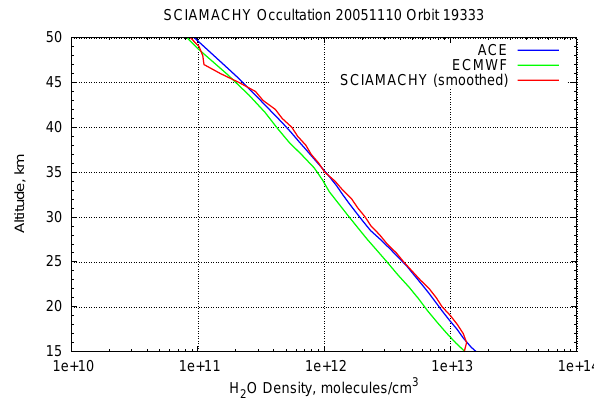
Fig. 7. SCIAMACHY water vapour profile on 10 Novem- ber 2005. Comparison of SCIAMACHY water vapour profile from 10 November 2005 with matching ACE and ECMWF profiles.